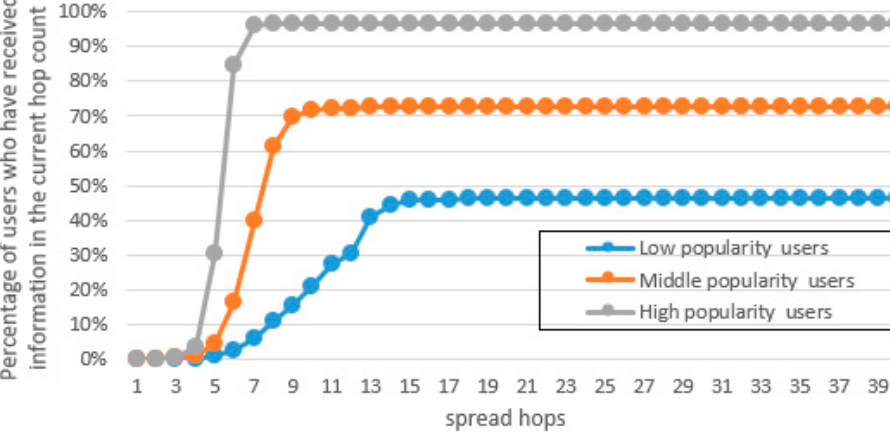
Figure 6. Range of privacy dissemination vs. popularity.